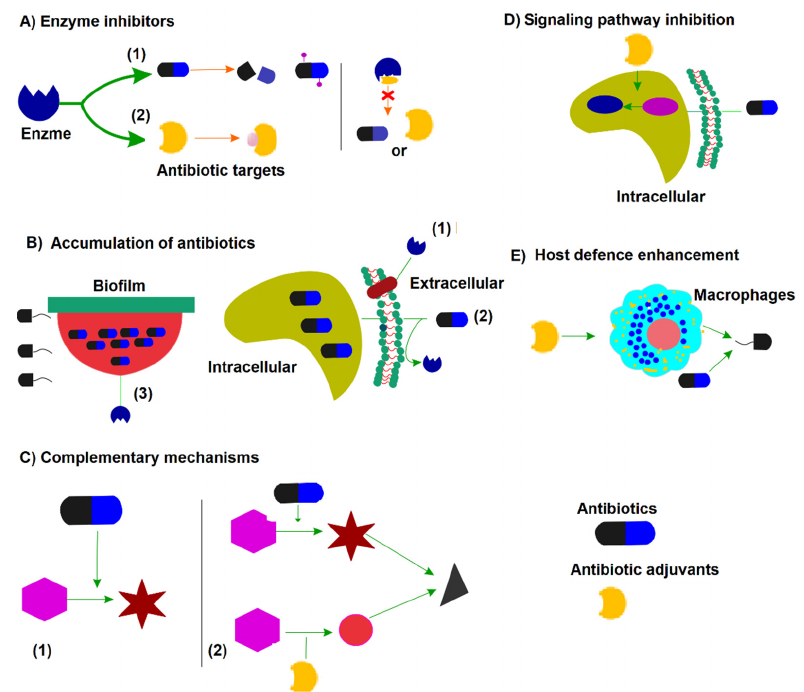
Figure 6. A schematic representation of the different mechanisms of action of antibiotic adjuvants. ( A ) Inhibition of hydrolase/modifying enzyme either on antibiotics as shown in (1) or the antibiotic targets as shown in (2); ( B ) enhancement of the intracellular accumulation of the antibiotic by the inhibition of efflux pumps as shown in (1), the facilitation of the antibiotic through the surface membrane as shown in (2) or the destruction of the biofilm as shown in (3); ( C ) the complementary mechanism; ( D ) inhibiting the signaling and regulatory pathway responsible for mediating the antibiotic resistance; ( E ) the enhancement of the host defense through the stimulation of the immune cells.